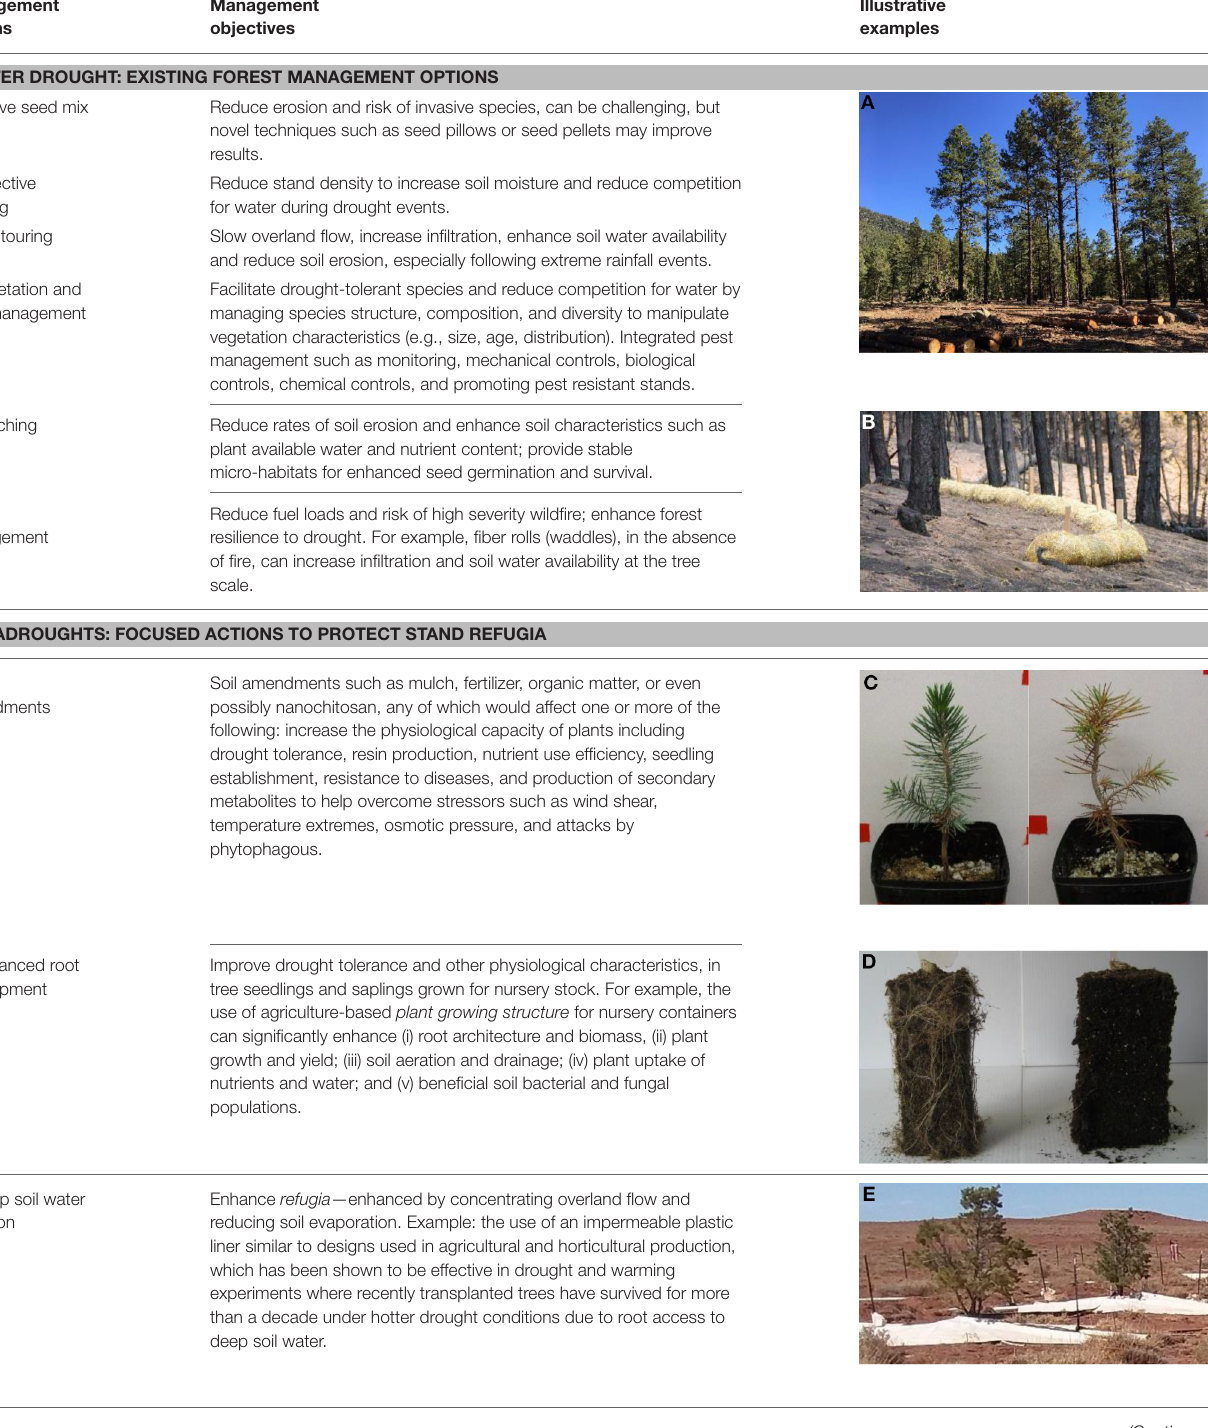
TABLE 1 | Possible management options and objectives for increasing forest resilience to hotter drought and multidecadal megadrought. Management